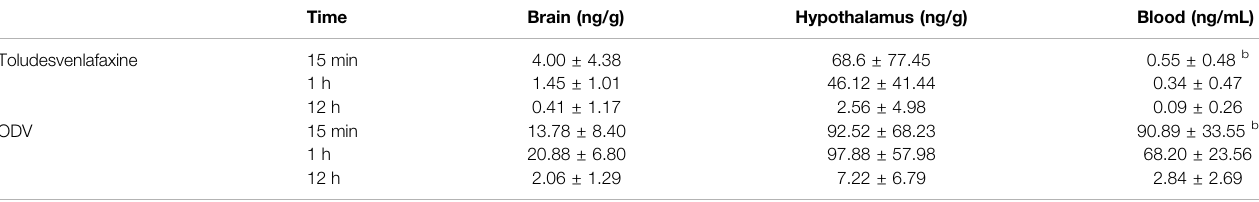
TABLE 5 | Blood, brain and hypothalamus tissue distribution of toludesvenlafaxine and ODV following intragastric administration of Toludesvenlafaxine at 8 mg/kg in